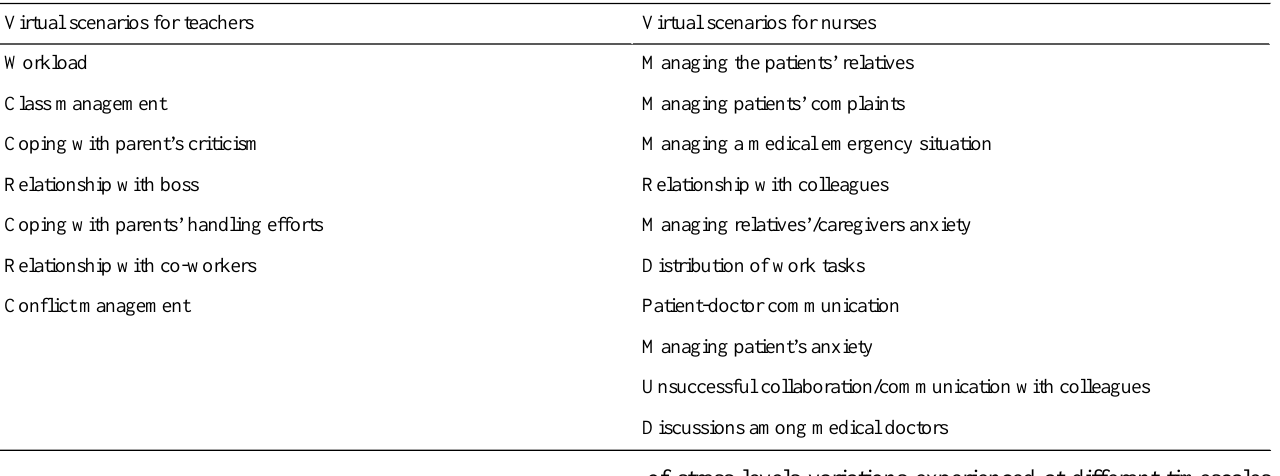
Table 2. The different virtual stressful